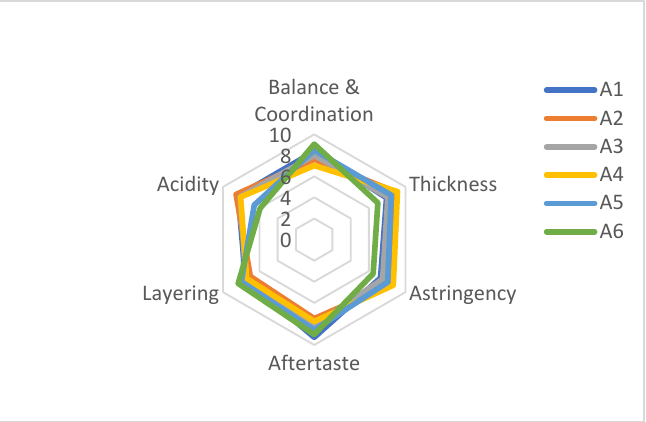
Figure 2. Radar chart for sensory evaluation of different varieties of wine. Note: A1—‘Hassan’; A2— ‘Zuoshaner’; A3—‘Beibinghong’; A4—‘Shuanghong’; A5—‘Zijingganlu’; A6—‘Cabernet Sauvi- gnon’.